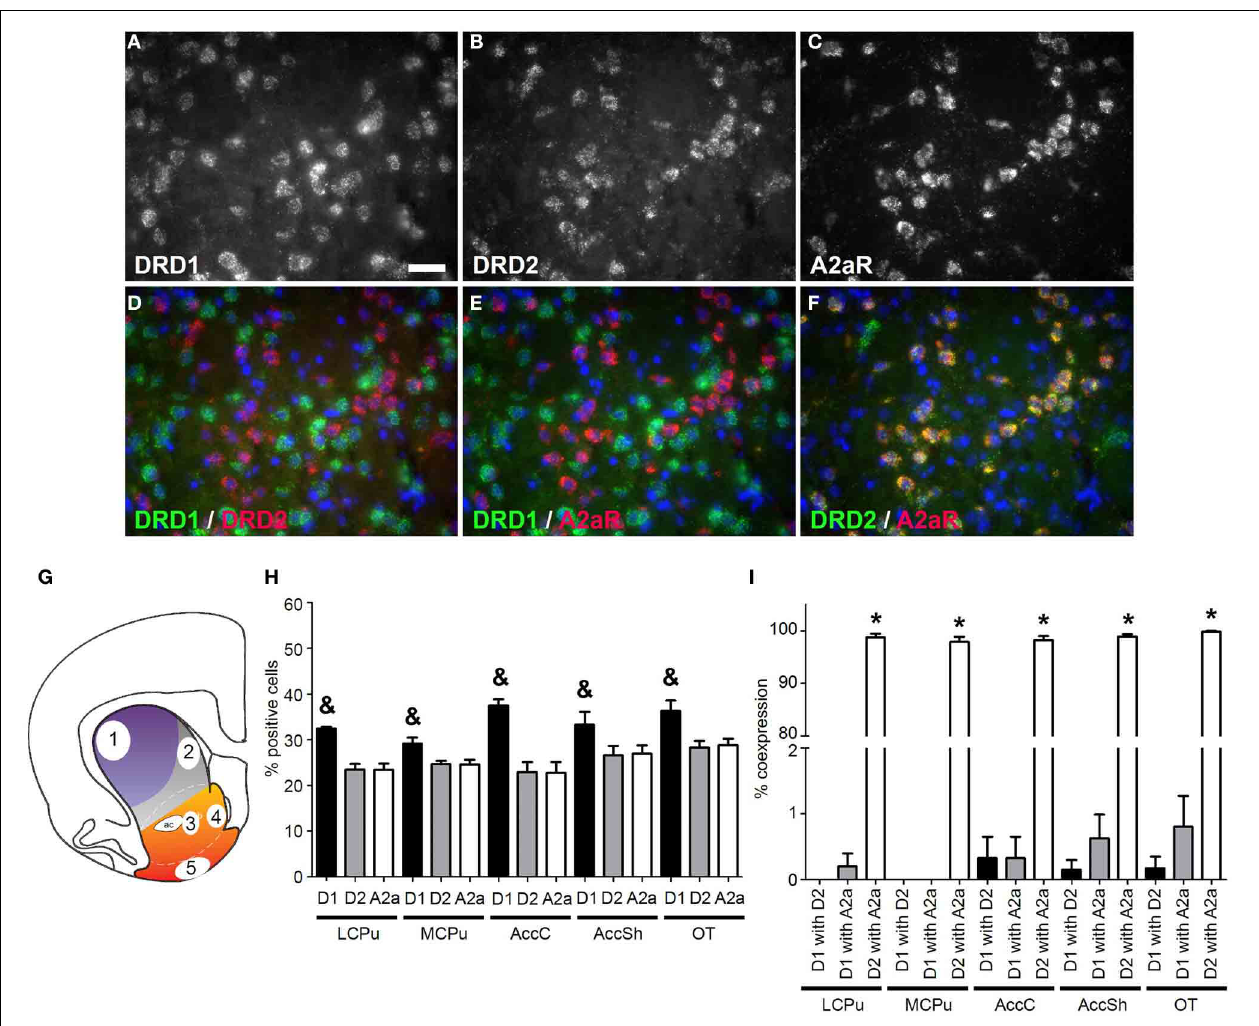
FIGURE 1 | Coexpression of the adenosine 2a receptor with both DRD1 and DRD2 . (A–F) Example of staining in the lateral caudate putamen (lCPu). Nuclei were stained using 4 (cid:4) ,6-diamidino-2-phenylindole (DAPI) (blue). Clear expression for the dopamine receptor D1 ( DRD1 ) (A) , the dopamine receptor D2 ( DRD2 ) (B) and the adenosine 2a receptor ( A2aR ) (C) . White bar, 25 μ m. (D,E) Virtually no coexpression was found for DRD1 and DRD2 and for DRD1 and A2aR . (F) Clear coexpression was found for DRD2 and A2aR . (G) Quantification of expression and coexpression was performed in several regions of the striatum: 1 = lCPu, 2 = medial caudate putamen (mCPu), 3 = nucleus accumbens core (AccC), 4 = nucleus accumbens shell (AccSh), 5 = olfactory tubercle (OT). Picture adapted from Voorn et al. (2004). (H) Quantification